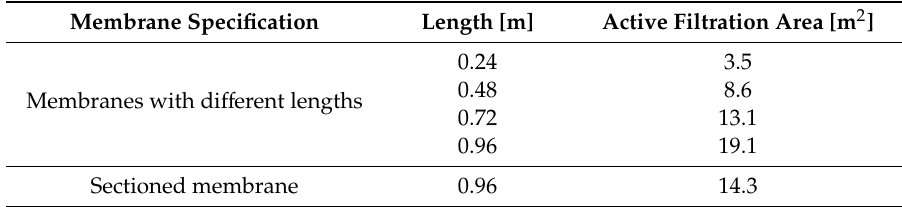
Table 1. Characteristics of prototype